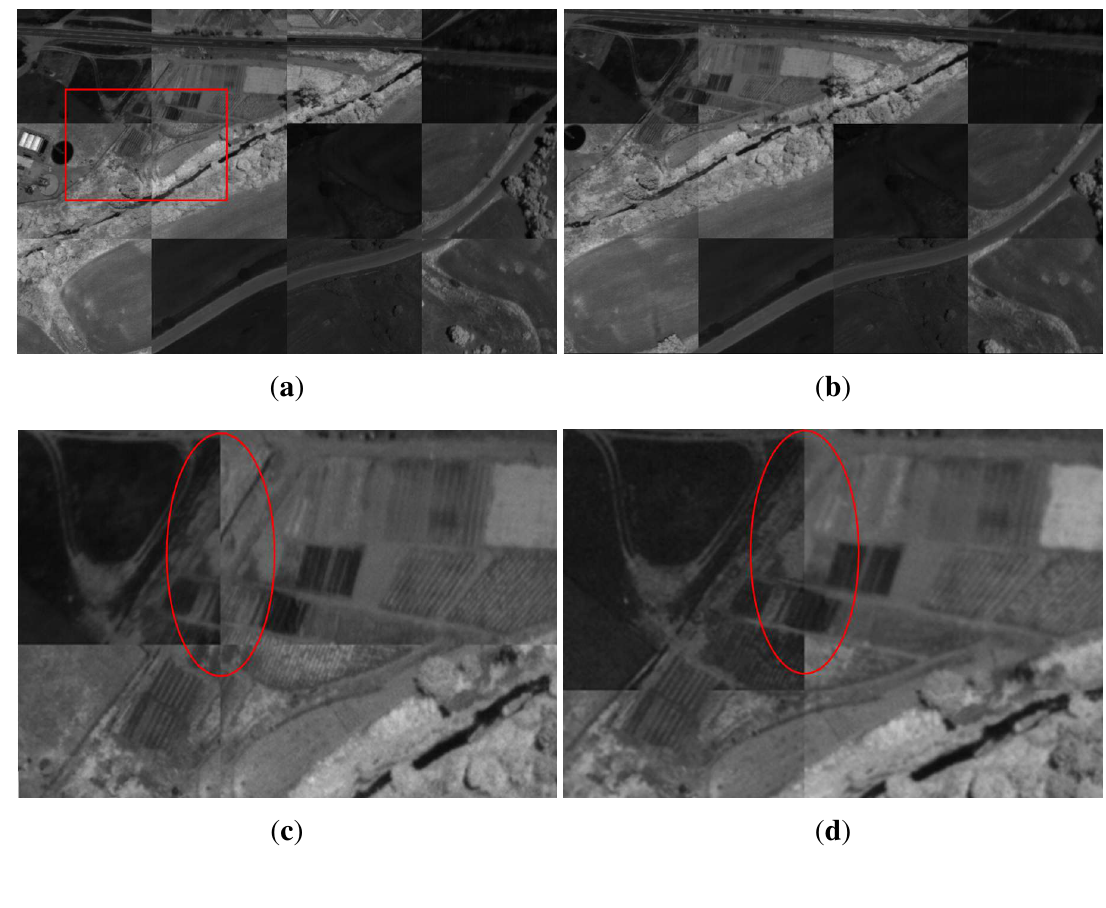
Figure 8. Registration results after the application of the developed methodology. The quantitative evaluation (Table 1) indicate an overall sub-pixel accuracy of approximately 0.35 pixels (dataset # 6) ( a ) Raw Unregistered Data; ( b ) Registered Data; ( c ) Zoom at Raw Data; ( d ) Zoom at Registered